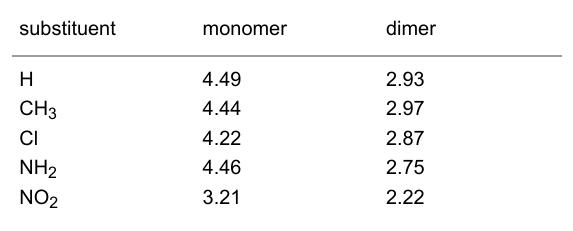
Table 2: Calculated HOMO–LUMO gaps E g (in eV) for substituted oligothiophenes compared to the unsubstituted